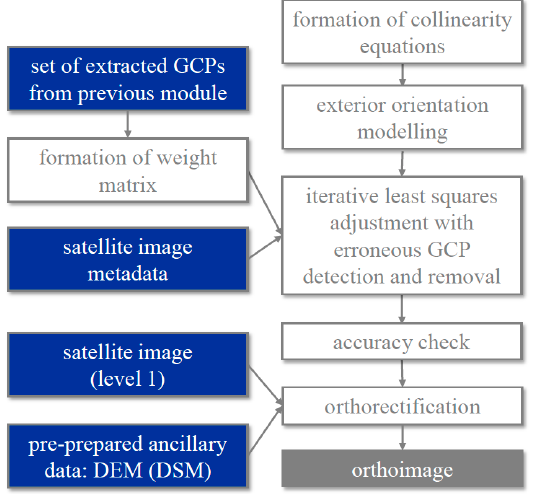
Figure 7. Workflow of the physical sensor model and the orthorectification sub-module.